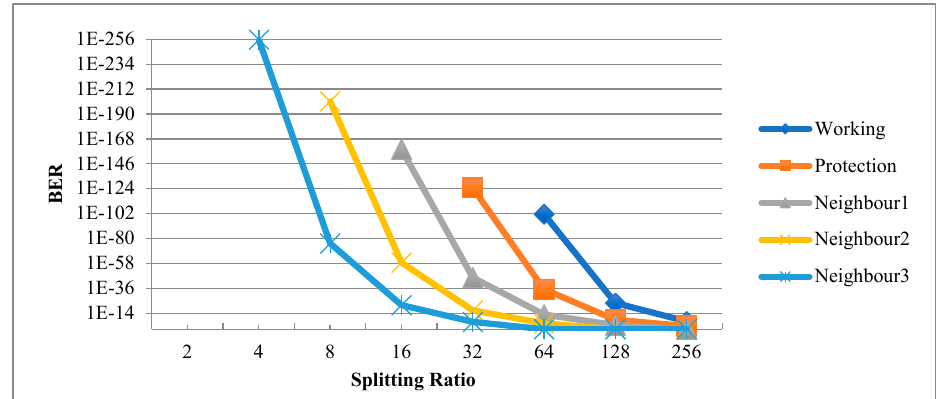
Figure 27. BER value based on the different protection link used based on the ‘zig-zag’ scheme.